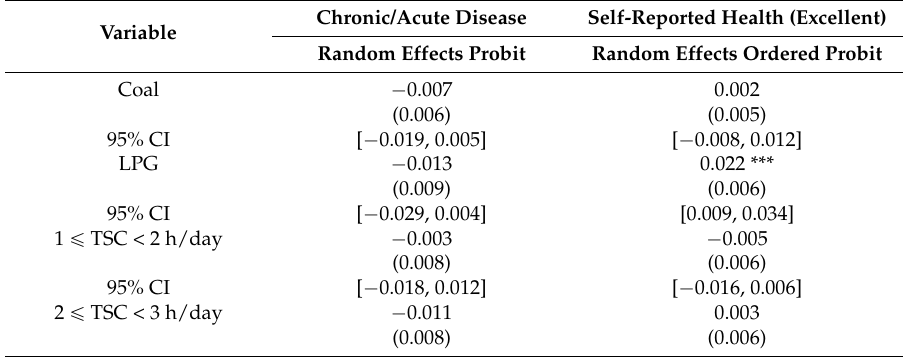
Table A5. Random effects (ordered) probit estimates for the effect of household cooking fuels on women’s health in rural areas: CHNS 1991–2009 (the test of attrition